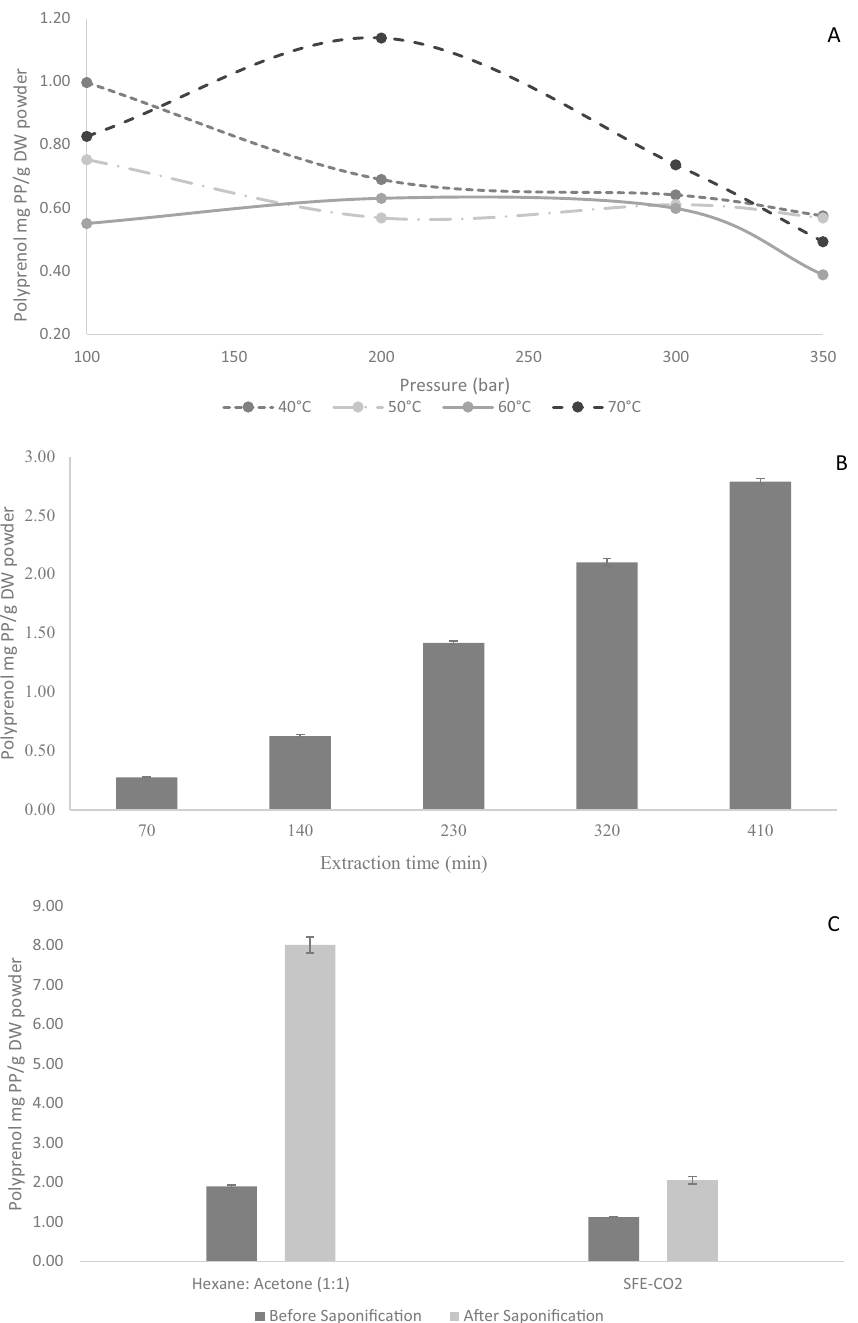
Figure 3. The effect of SFE-CO 2 parameters ( A ) effect of pressure and temperature and ( B ) dynamic time ( C ) effect of saponification on the total polyprenol content in mg/g DW at a constant temperature of 70 and pressure of 200 bar with a presence of ethanol as co-solvent. During the time course of the SFE-CO 2 of C. atlantica ‘Glauca’ extracts were collected at different time intervals and samples were analysed for total polyprenol using HPLC. Each value presents the mean value ± SD. Figures prepared using Microsoft excel (Version 16.39, Microsoft 365 subscription, data analysis 2019